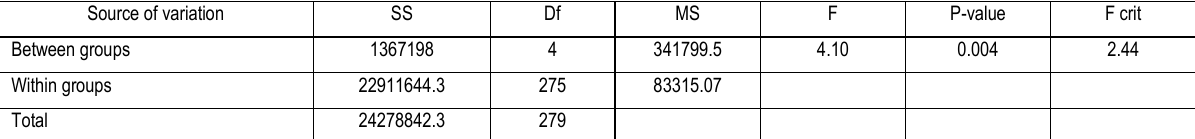
Table 7. Analysis of Variance result for comparing daily expenditure on charcoal by petty traders Source of variation